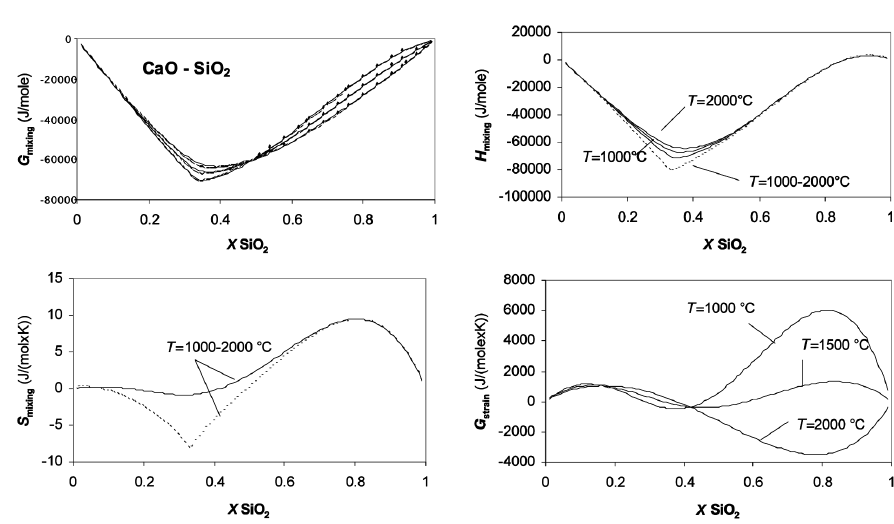
Fig. 9. HPM themodynamic parameterization of CaO-SiO 2 system (solid lines; Ottonello and Moretti, 2004), compared with estimates of modified quasi -chemical model (dashed lines; Pelton et al. , 1995).